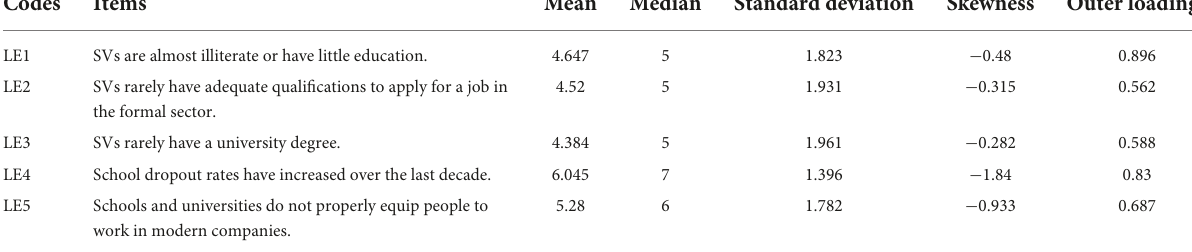
TABLE 3 Measurement properties of lack of education.